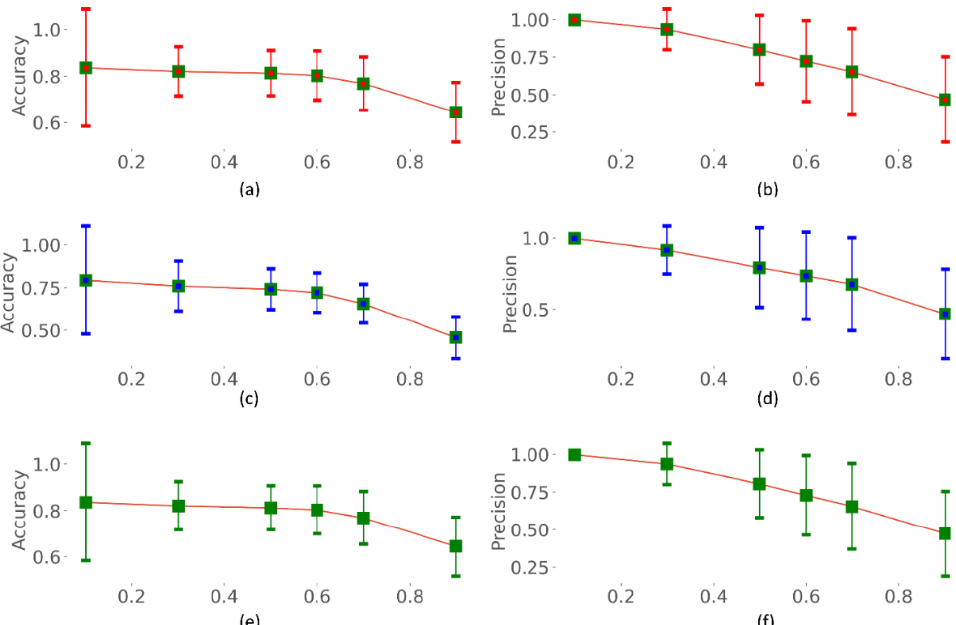
Figure 7. Accuracy and precision measured for varying values of τ . ( a , b ) using aleatoric uncertainty; ( c , d ) using epistemic uncertainty; and ( e , f ) using total (aleatoric + epistemic) uncertainty.